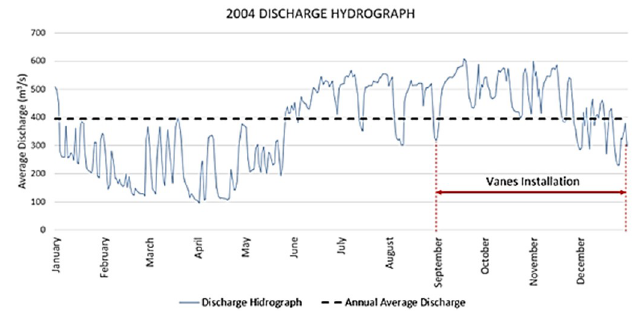
Figure 8. Sinú River, Trementino: daily flow series in 2004 (Source: Limnimetric Station The Doctrine, IDEAM).